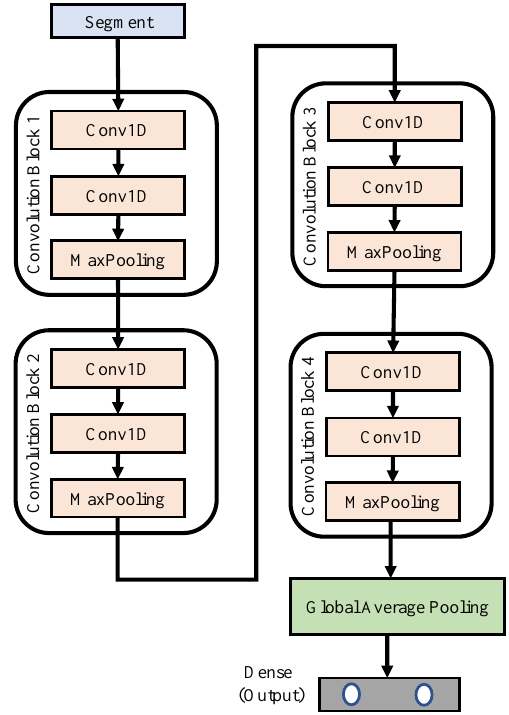
Figure 7. Block diagram of the proposed 1D CNN networks.